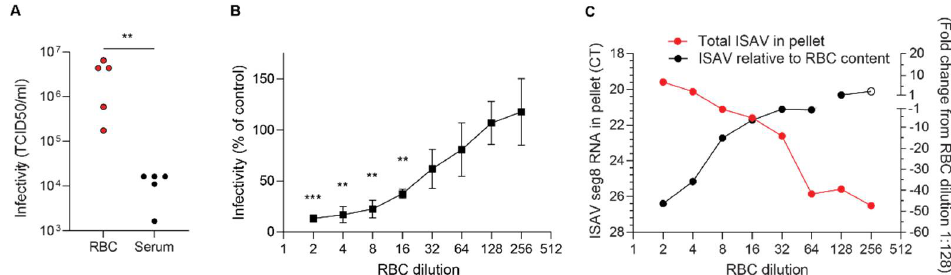
Figure 7. Erythrocytes sequester infective ISAV particles and inhibit serial infection of cultured cells. ( A ) Density gradient-purified erythrocytes (RBC) and plasma samples were harvested from ISAV-infected fish (13 d.p.i. in the 2020 trial) and inoculated on ASK cells. Data points represent samples from individual fish. ** p = 0.079, Mann–Whitney U. ( B ) Serially diluted RBC from healthy fish were added to infected ASK cells 24 h p.i. and incubated another 24 h before supernatants were transferred to new ASK cells. Infection of ASK cells 72 h.p.i. was measured by immunostaining for ISAV NP and automated quantification of the number of infected cells (Spectramax i3x plate reader, minimax 300 Imaging Cytometer module, Molecular devices, CA, USA). The infectivity graphs show medians (dots) and 95% confidence intervals (bars), representative of two independent